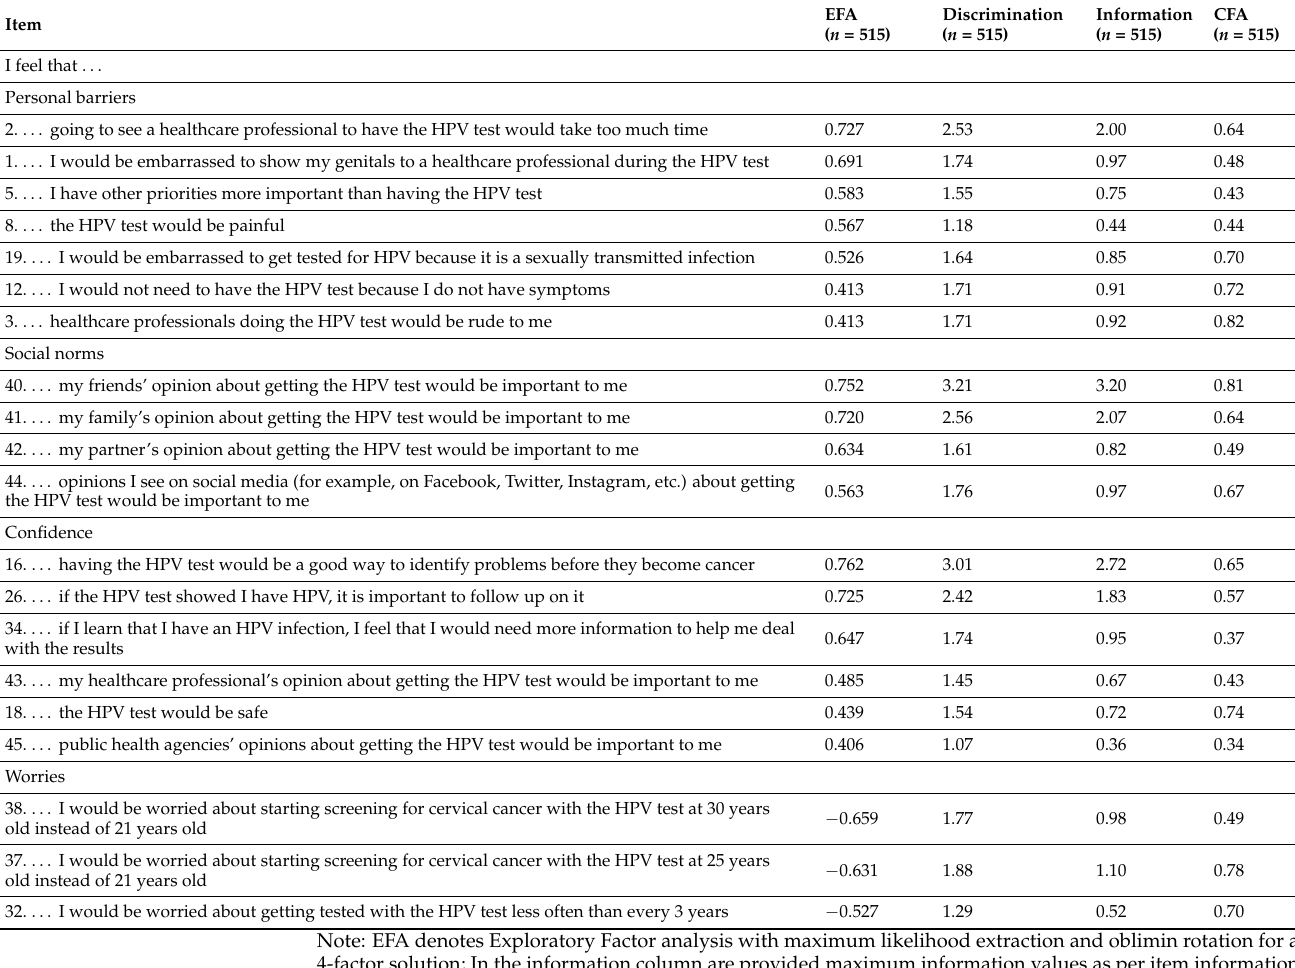
Table 2. Results of factor analyses and IRT analyses for the final items of the HPV Testing Attitudes and Beliefs Scale items (20 items).